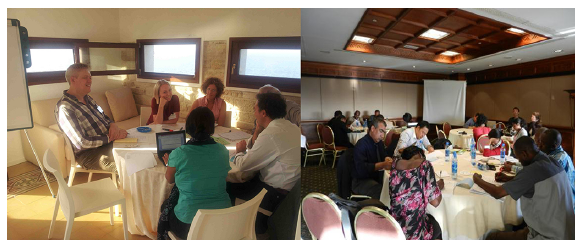
Figure 3. Some of the Think Tank members in discussion at the CATALYST regional workshops for the European Mediterranean, held in Italy (left), and for East and West Africa, held in Ethiopia (right), in